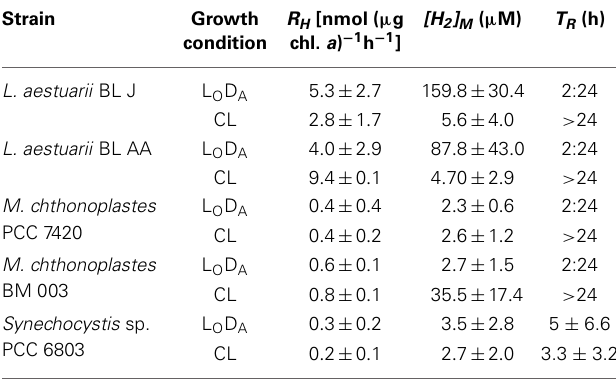
Averages ± standard deviation with n = 3 independent determinations shown for each strain and condition. CL, Continuous Light; L O D A , Light Oxic and Dark Anoxic, 12-h cycles.